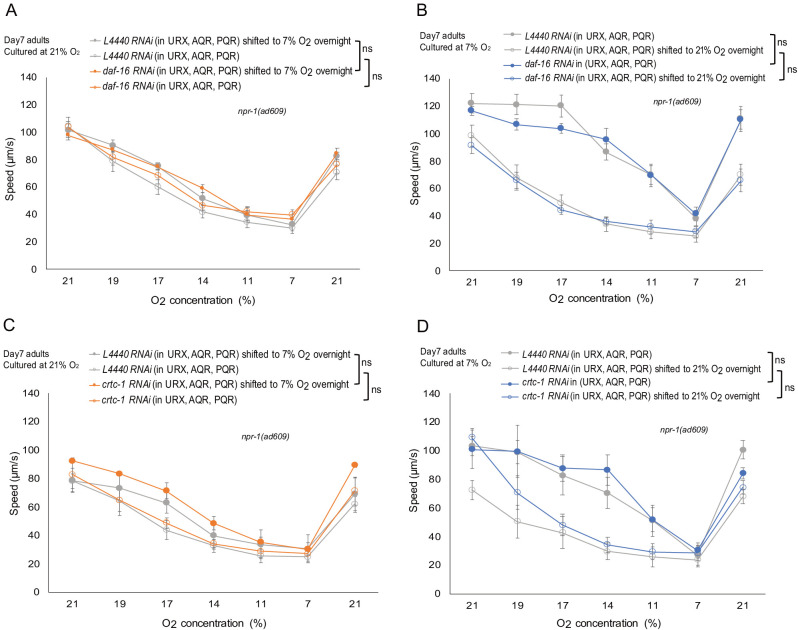
O2-evoked speed responses of day 7 adults with daf-16 or crtc-1 specifically knocked down in O2-sensing neurons.(A–B) O2-evoked speed responses of day 7 adults were not affected by daf-16 specifically knockdown in O2-sensing neurons. n = 5–6 assays per condition. Mean ±sem, ns, p>0.05. (C–D) O2-evoked speed responses of day 7 adults were not affected by crtc-1 specifically knockdown in O2-sensing neurons. n = 4 assays per condition. Mean ±sem, ns, p>0.05.